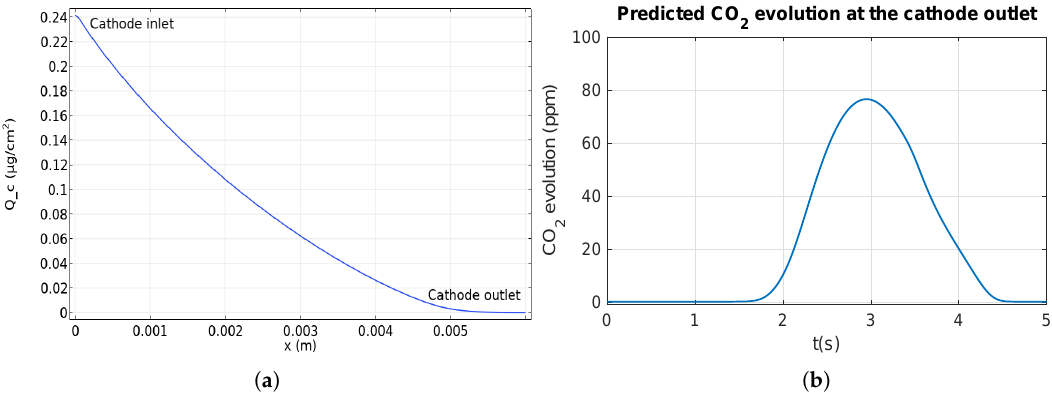
Figure 5. Cumulative carbon loss distribution at different locations at the cathode ( a )and amount of CO 2 at the cathode outlet ( b ) during a